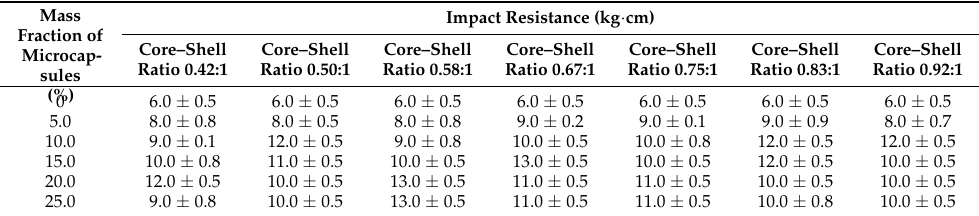
Table 5. The impact resistance of the coatings.